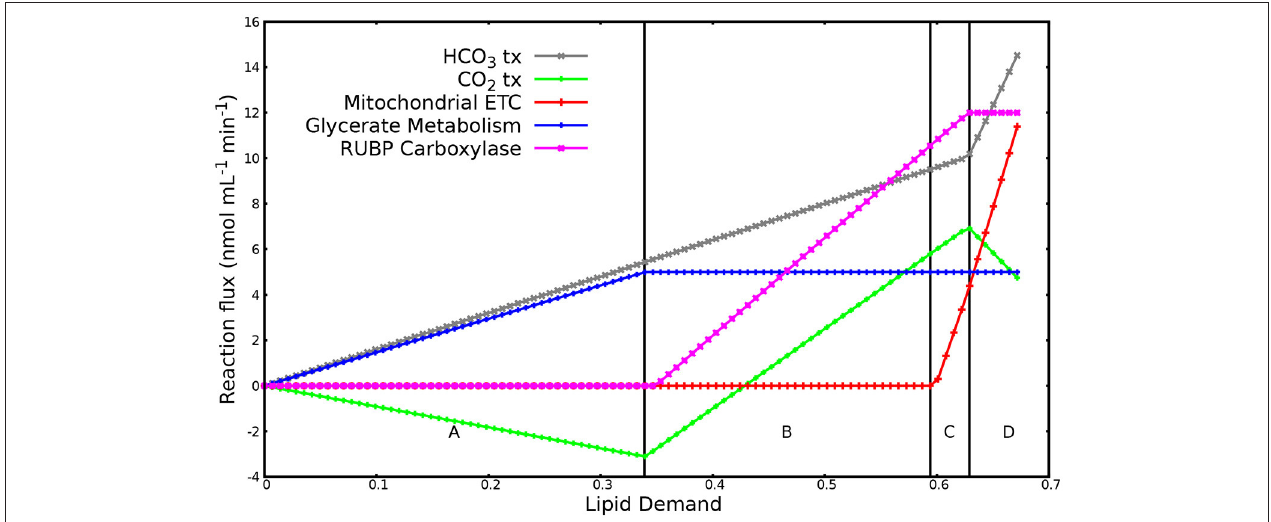
FIGURE 1 | Reaction responses to increase in lipid demand. The plot has been divided into four major regions labeled A to D based on the flux patterns. Region A: reaction response when flux in glycerol uptake, photon flux, and rubisco reaction is not saturated. Region B: reaction response when flux in glycerol transporter saturates. Region C: reaction response when photon flux saturates. Region D: reaction response when flux in Rubisco reaction saturates. Negative flux denotes export of substrate out of the system while positive flux denotes import of substrate into the